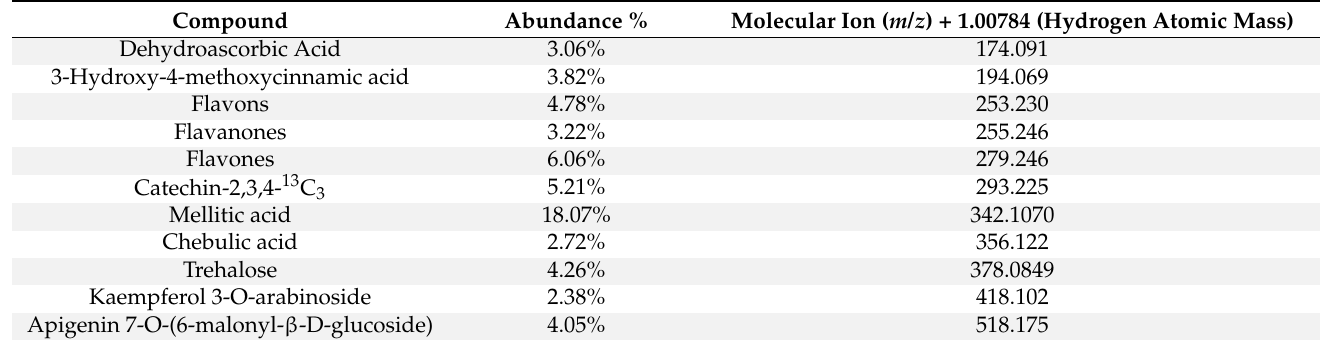
acetonitrile–water extract, with relative abundance percentage and molecular ion ( m / z ) + 1.00784 (atomic mass of